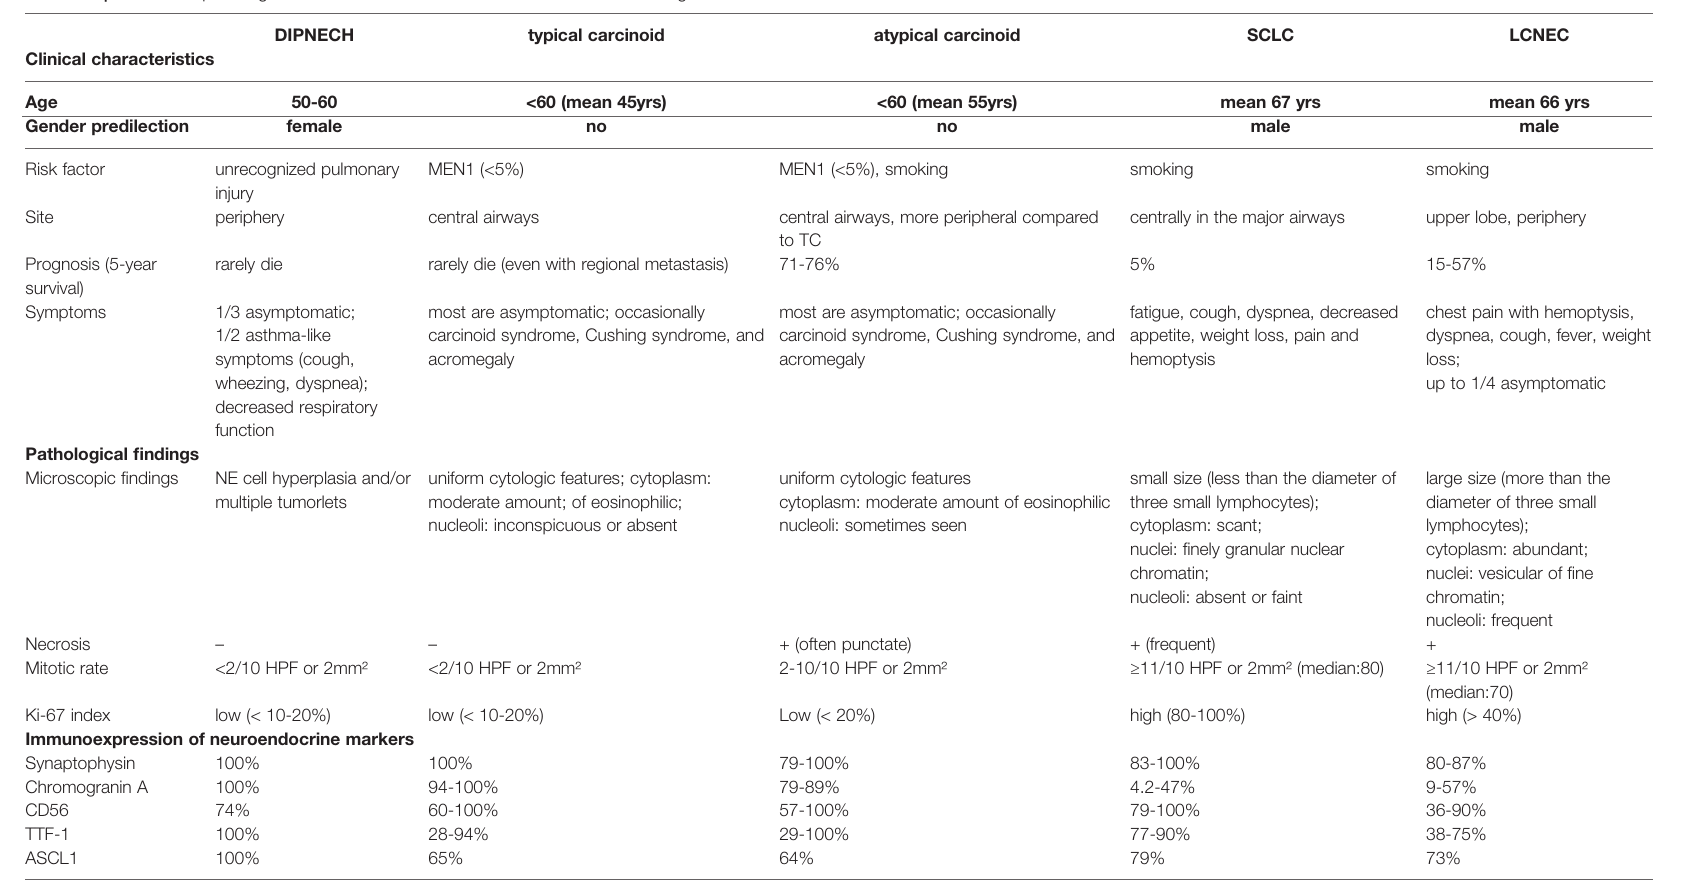
TABLE 1 | Main clinicopathological characteristics of neuroendocrine tumors of the